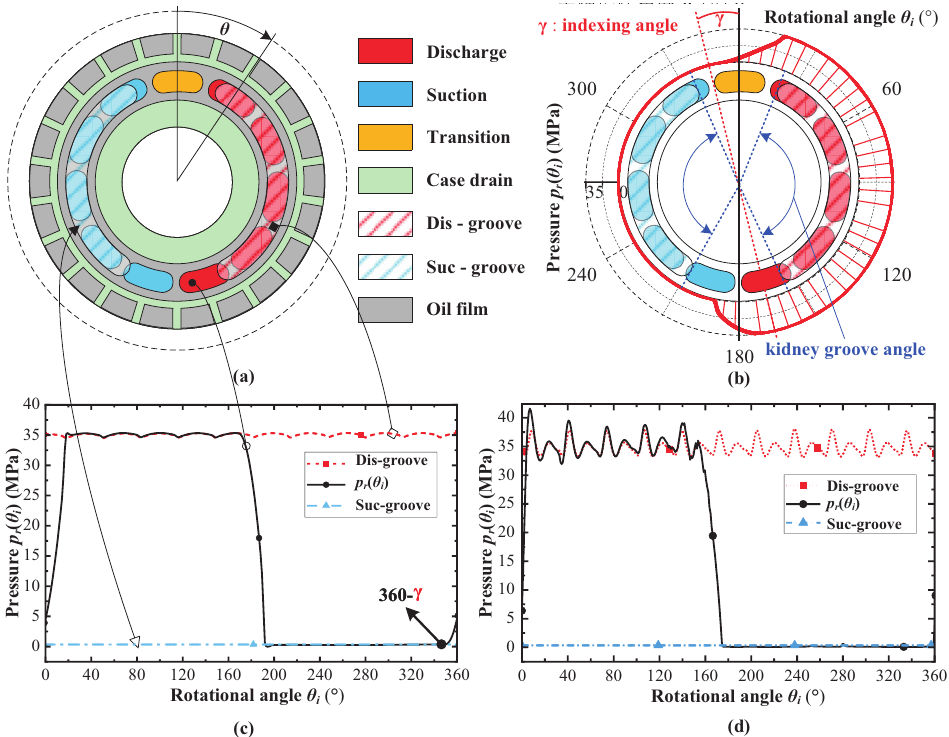
Figure 10. Comparison of p r ( θ i ) curves. ( a ) Pressure boundary. ( b ) Indexing angle. ( c ) p r ( θ i ) curves from the lumped parameter model. ( d ) p r ( θ i ) curves from the CFD model. Combining the pressure boundary obtained in Figure 10 and the dynamic boundary (Equations (17)–(19)) calculated using the multi-body dynamics model, the overturning force and moment of the cylinder block are calculated and shown in Figure 11a. Figure 11b–d shows the polar plots of the overturning force F v and the moments ( M cx and M cy ) on the cylinder block as a function of the rotational angle of the drive shaft, respectively. The overturning force F v varies in the range of 34.5 ∼ 39 kN and the overturning moments M cx and M cy vary between − 170 ∼− 50 N · m and − 820 ∼− 790 N · m, respectively. Since the pistons are spaced evenly around the centerline of the cylinder block, the petal-shaped overturning force and moment curves have a variation period of 2 π / N p . The overturning moment of the cylinder block is mainly due to the pressure difference between the oil- suction and -discharge kidney grooves, inertial force, and centrifugal force of the piston- slipper assembly. When the APP operates under high-pressure and low-speed conditions, the influence of the pressure difference between the oil-suction and -discharge kidney grooves is dominant and the absolute value of M cy is much larger than that of M cx . When the APP operates under low-pressure and high-speed conditions, the influence of the inertial force and centrifugal force of the piston-slipper assembly is dominant and the absolute value of M cy is slightly larger than or even smaller than that of M cx